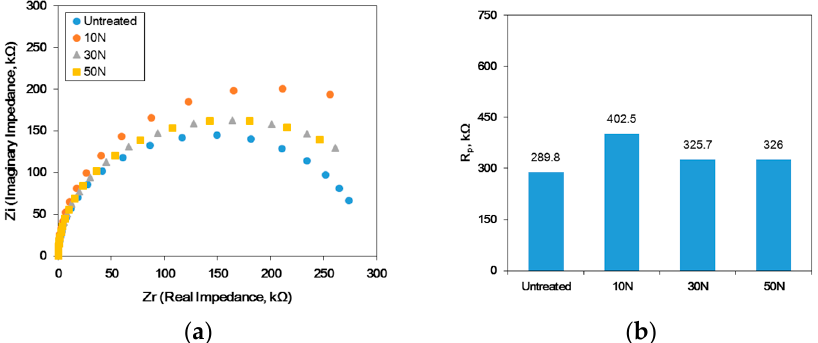
Figure 12. The effect of the static load in UNSM treatment on the AC impedance measurement for the passive film formed at 0 V (saturation camel electrode, SCE) in deaerated 1% NaCl at 30 °C: ( a ) Nyquist plot and ( b ) polarization resistance.